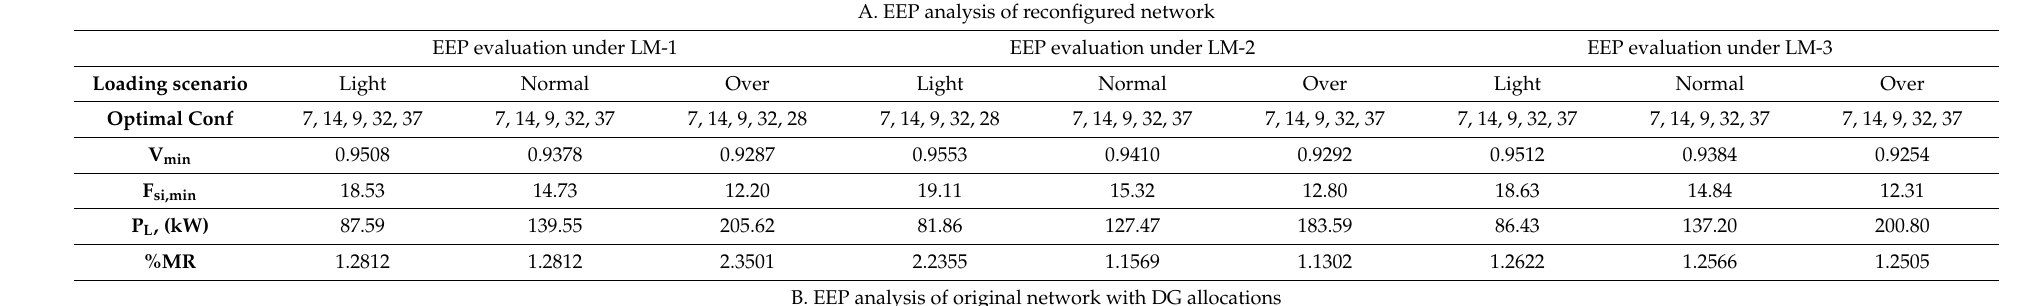
Table 6. EEP for Case-1 (reconfiguration and DG allocation